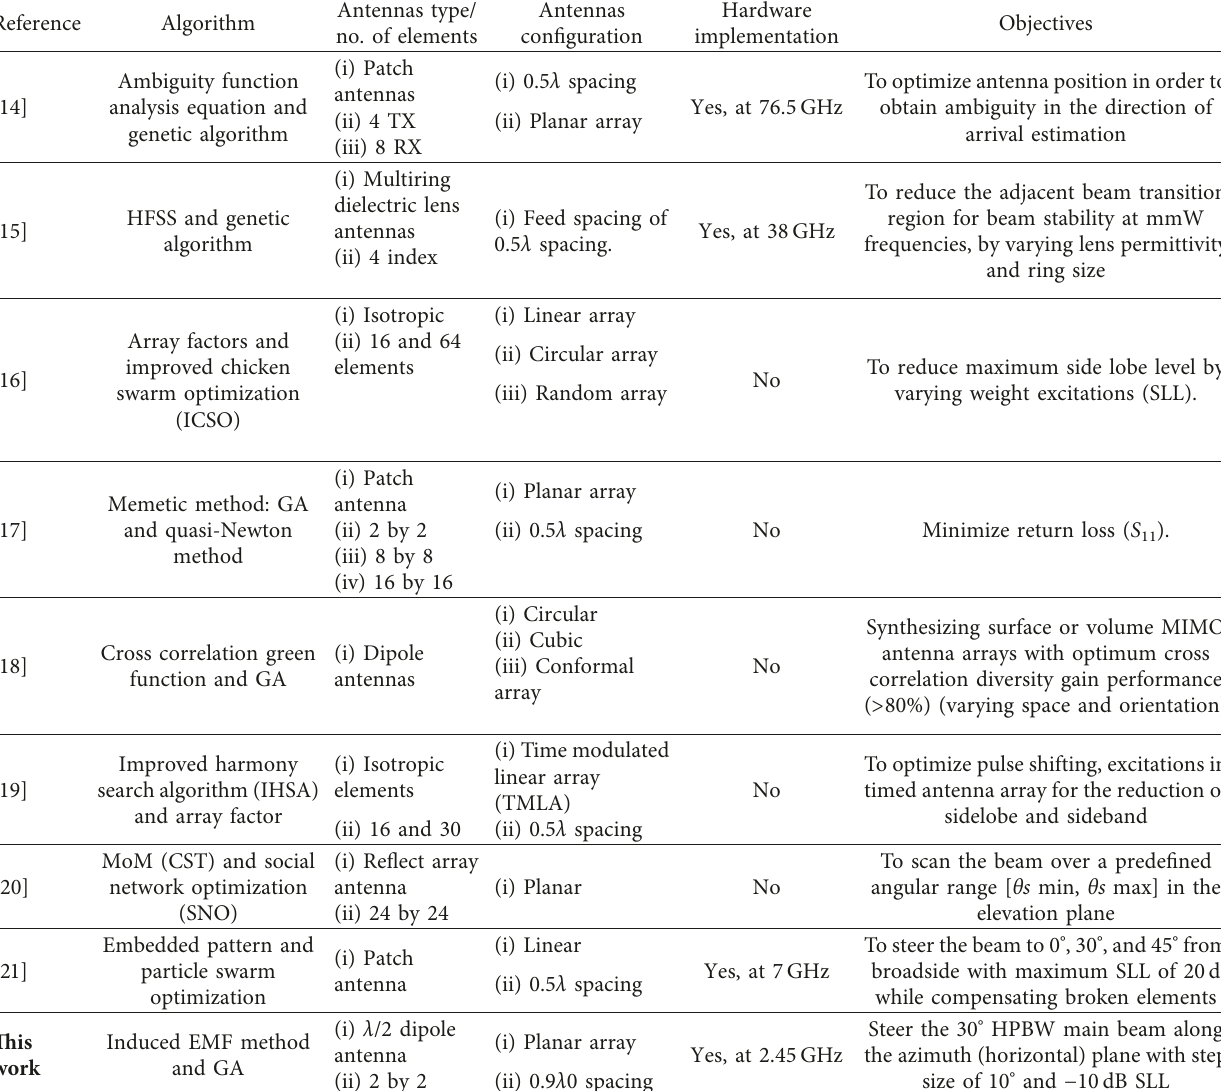
Table 4: Comparison of this work and previous